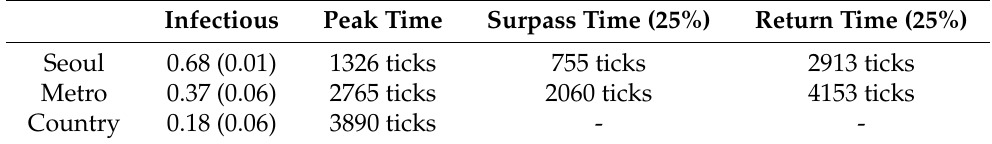
Figure 6. Experimental results for No-control (with different density of population). Blue line (- -): Susceptible, Red line (-): Infectious, Green line (-): Recovered. ( a ) Seoul (peak: 0.68, 1326 ticks); ( b ) Metro city (peak: 0.37, 2765 ticks); ( c ) Country (peak: 0.18, 3890 ticks); ( d ) Infectious for all areas. Table 1. Summary of results